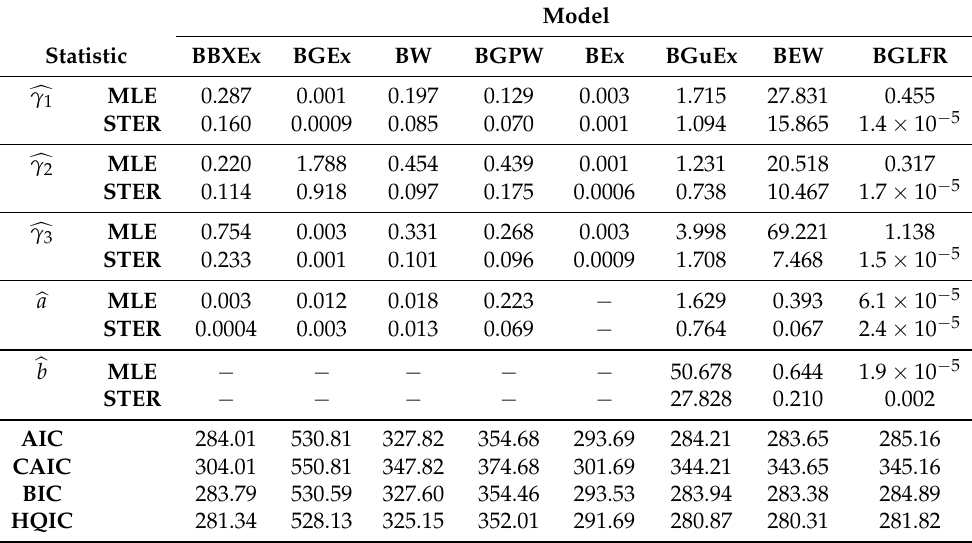
Table 15. The MLEs and goodness-of-fit measures based on the censored sample at r = 7.